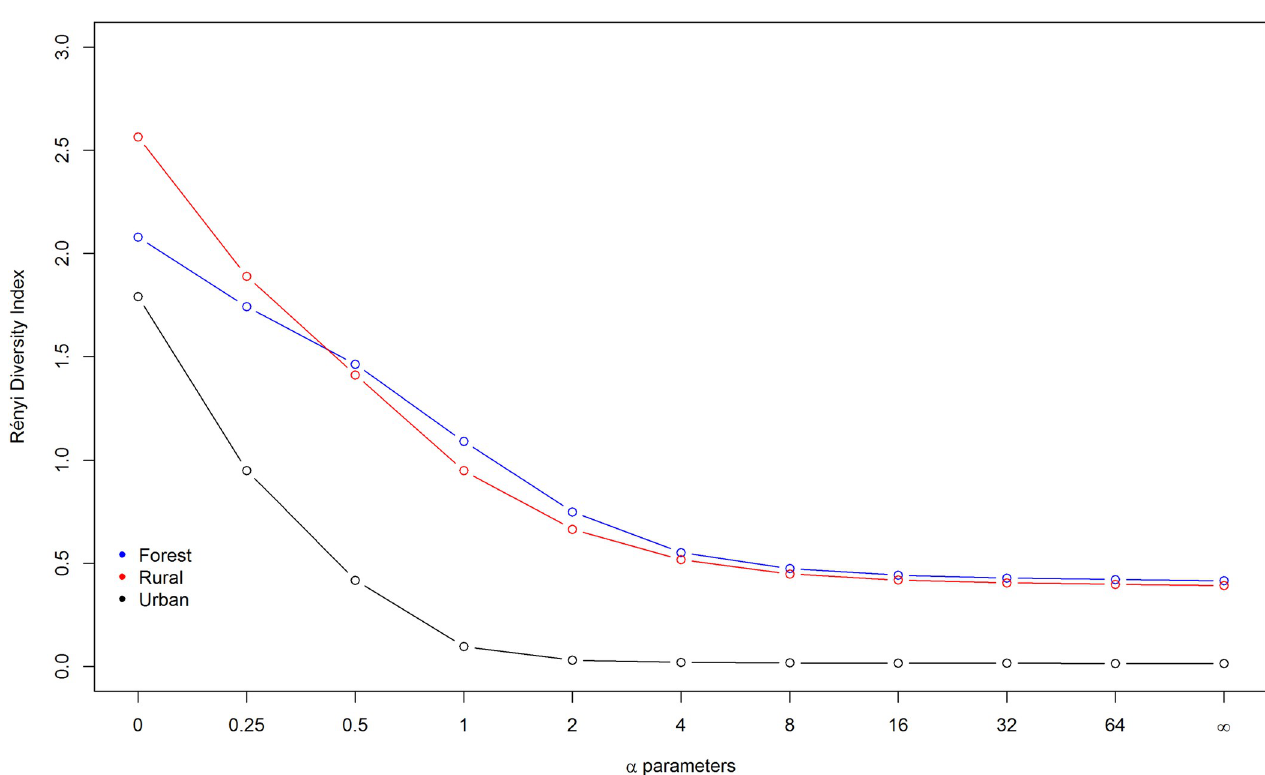
Fig 8. Species richness and diversity profiles of Re´nyi, showing Shannon index ( H ) ( α = 1) and Simpson index (S) ( α = 2) diversity in the three sampled areas (forest, rural and urban). Corumba´, Mato Grosso do Sul, Brazil. May 2015 to April 2017.